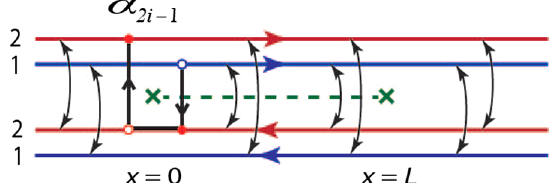
FIG. 3. The defects (genons) can be viewed as domain walls between two different ways of generating an energy gap in the counterpropagating edge states (double arrows indicate interedge electron tunneling). The zero-mode operator α 2 the quasiparticle hopping process shown in the figure, projected into the ground-state subspace of the edge